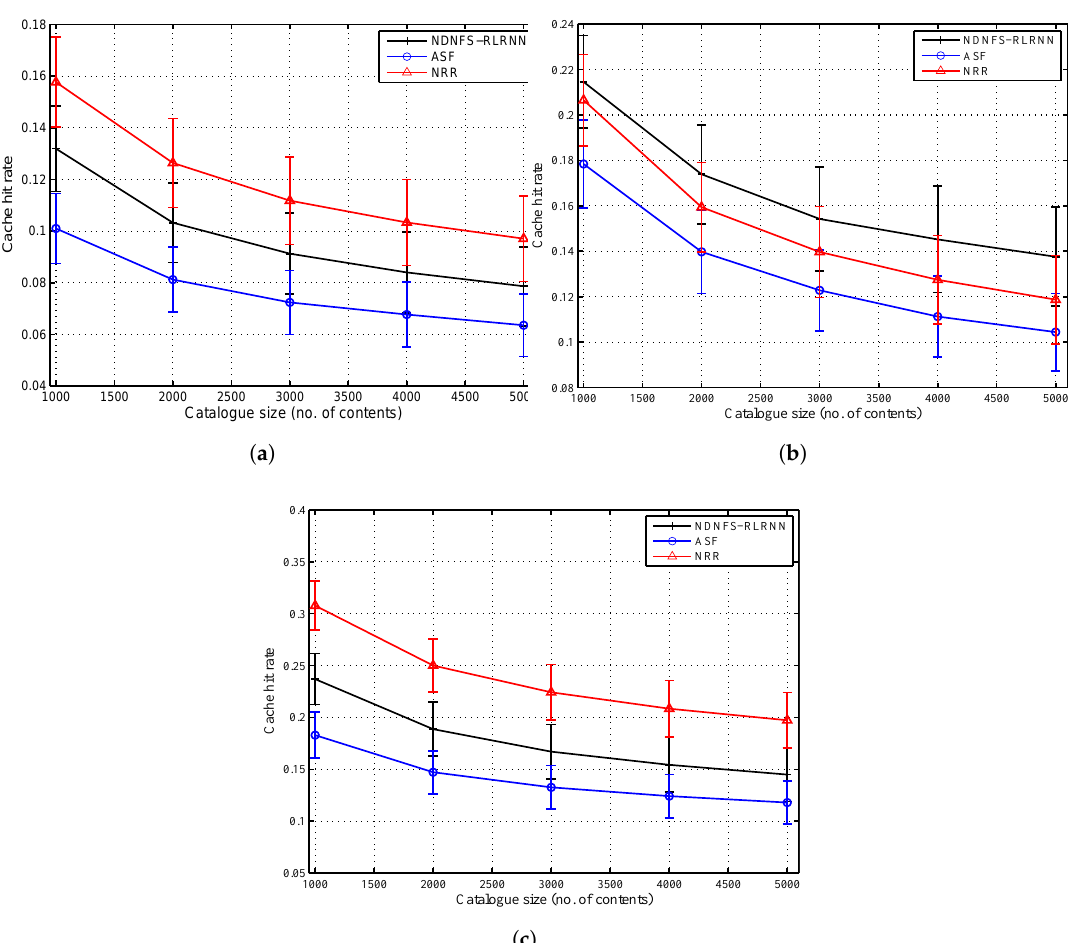
Figure 4. Cache hit rate performance of NDNFS-RLRNN ( p = 0.3), ASF and NRR for different